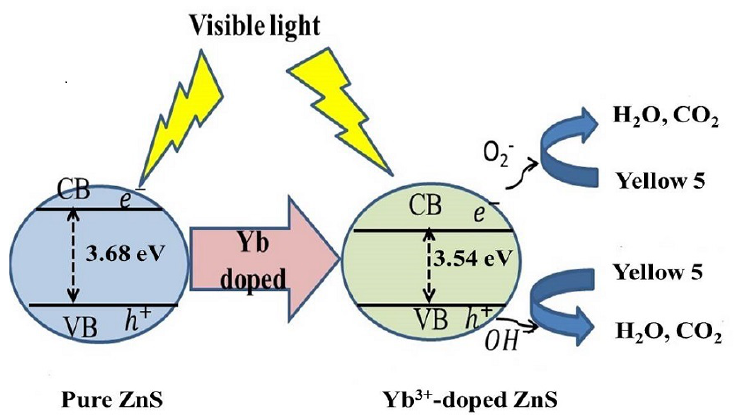
Fig. 8. The schematic illustration of photocatalysis